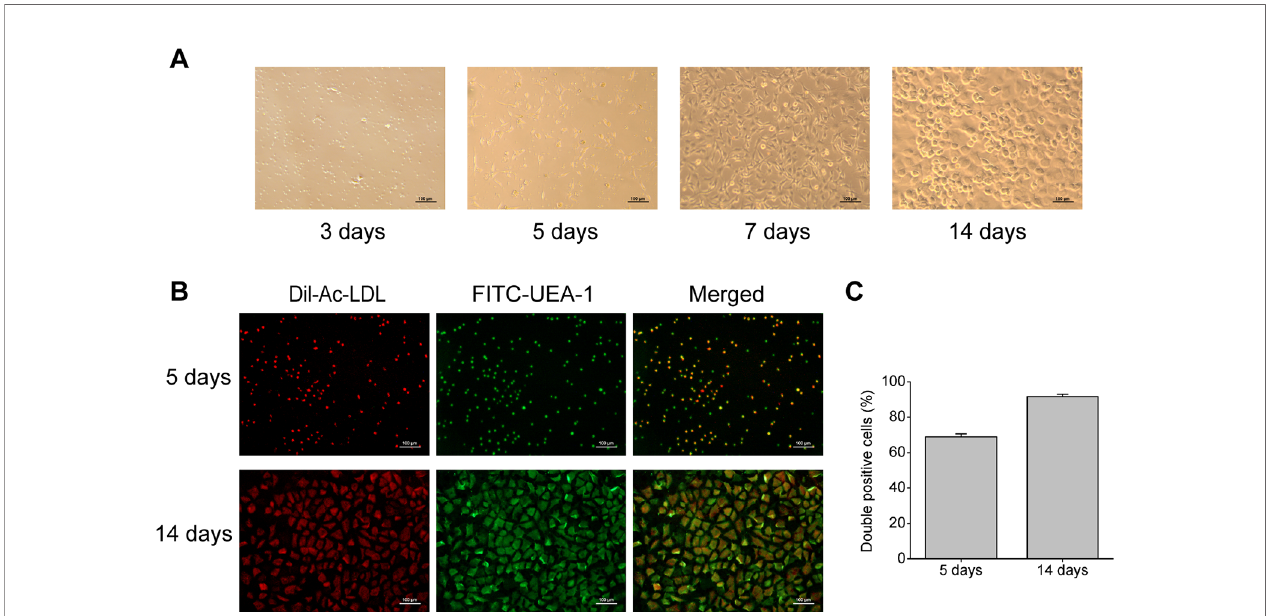
FIGURE 1 | Characterization of rat bone marrow-derived EPCs. (A) Representative images of rat bone marrow-derived EPCs on the 3rd, 5th, 7th, and 14th day of culture (100× magni fi cation). (B) Immuno fl uorescent images indicating Dil-Ac-LDL (red) incorporation and FITC-UEA-1 (green) binding by EPCs (100× magni fi cation). (C) Quantitative analysis of the double positive